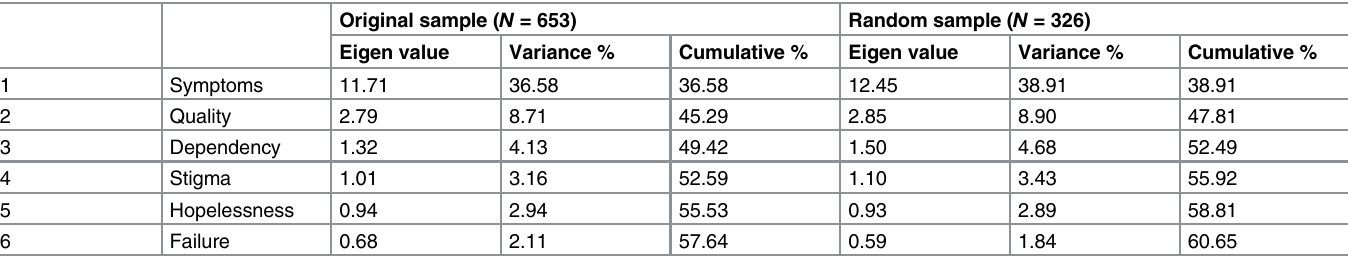
Table 3. Stability analysis of the six-factor solution using a randomly selected